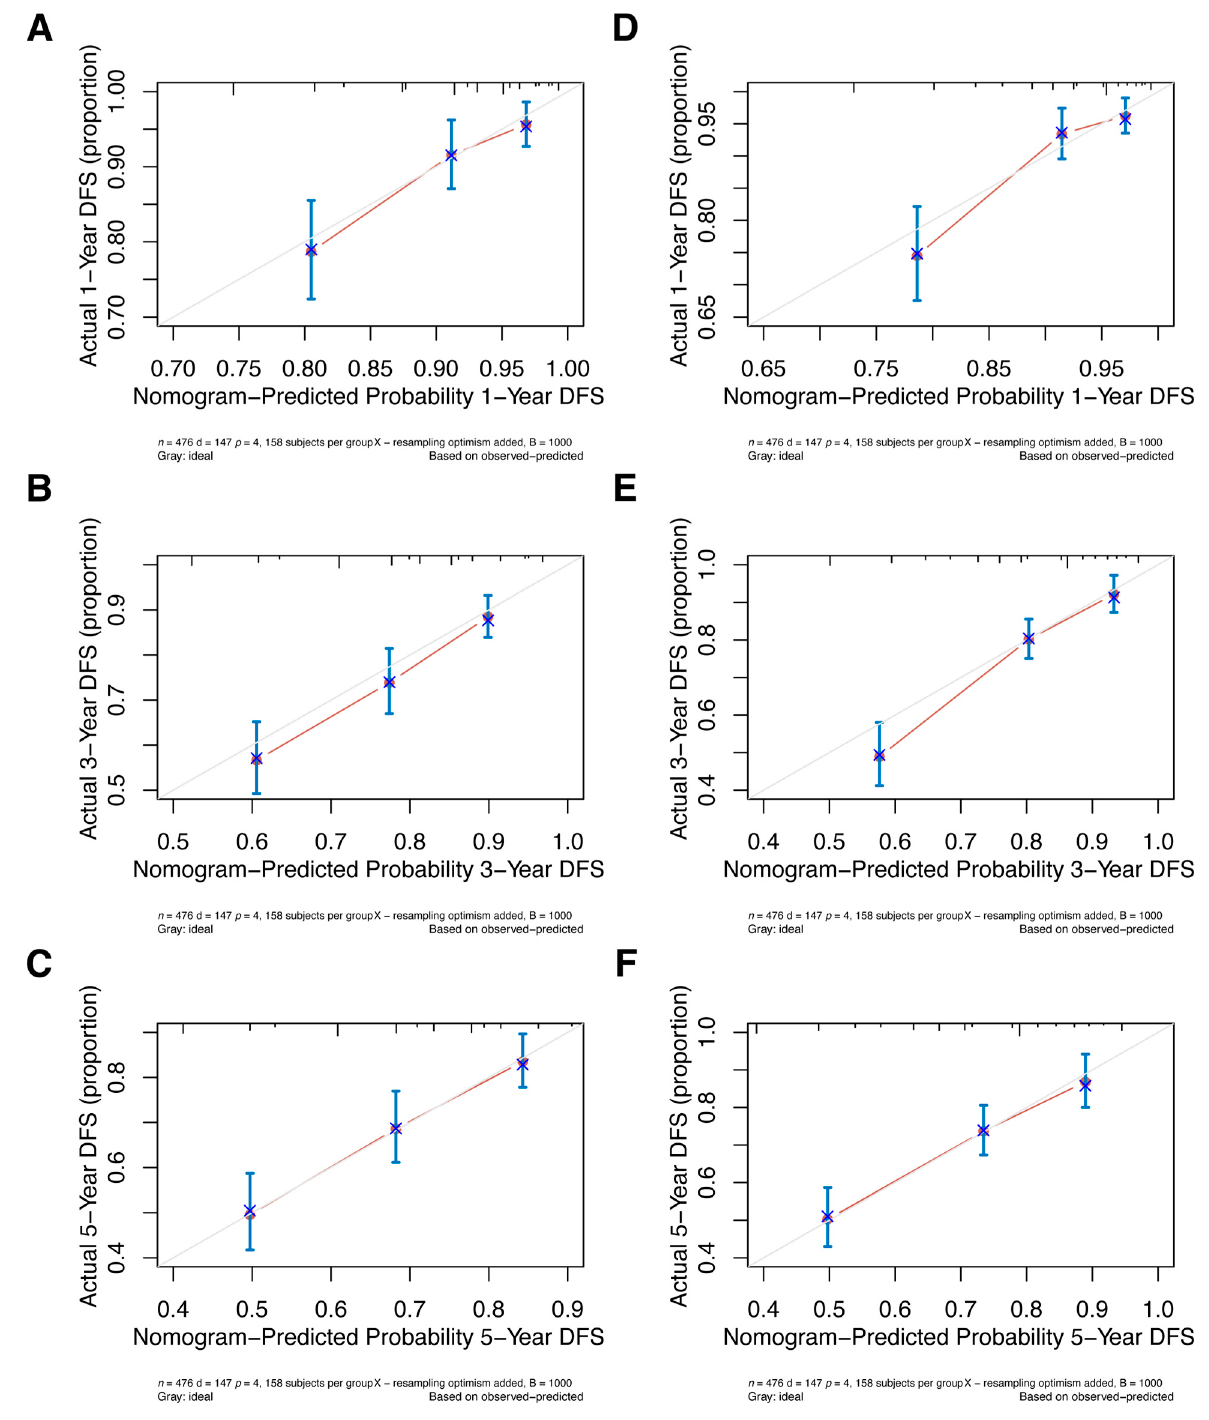
Figure 7. The pre-NAC nomogram model calibration plot for ( A ) 1-, ( B ) 3-, and ( C ) 5-year DFS in the primary cohort; the post-NAC nomogram model calibration plot for ( D ) 1-, ( E ) 3-, and ( F ) 5-year DFS in the primary cohort. Abbreviations: NAC, neoadjuvant chemotherapy; DFS, disease-free sur ‐ vival.